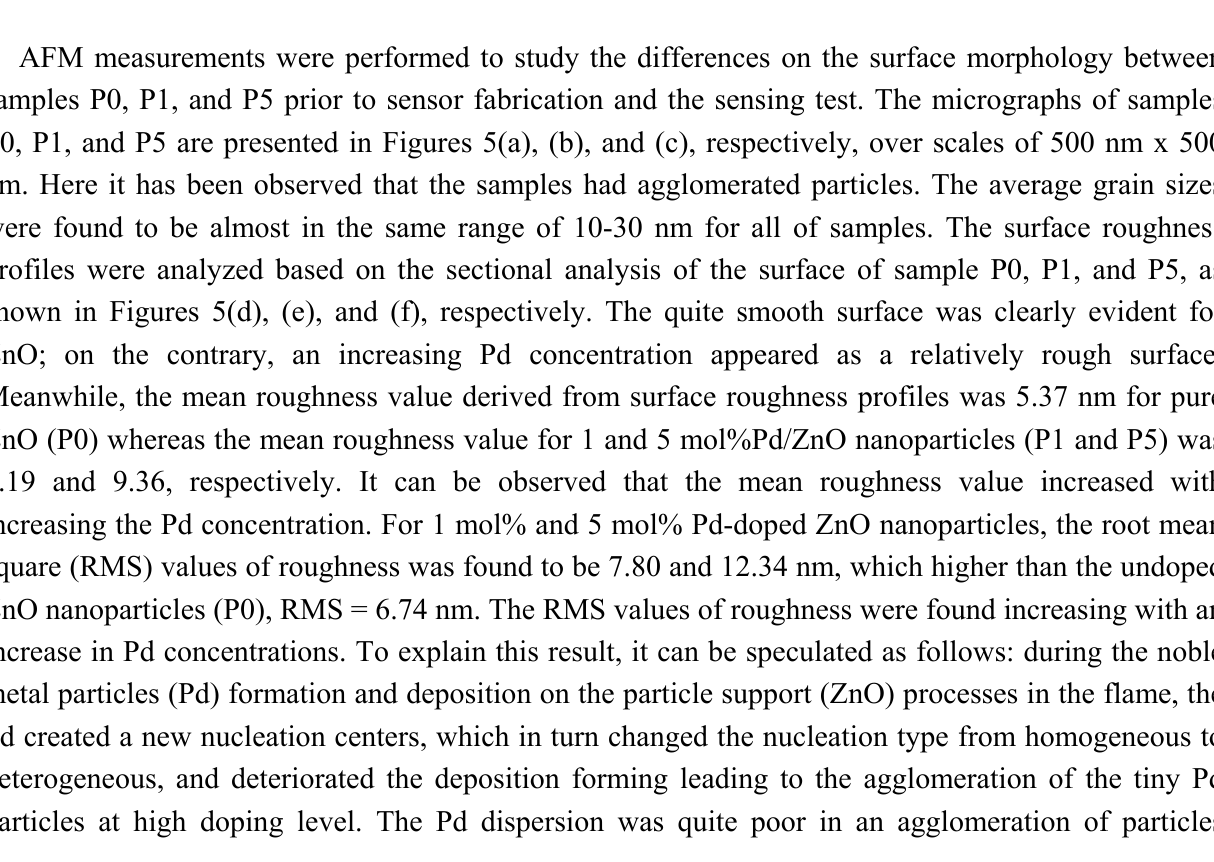
), d , and d average sizes as a function BET BET XRD